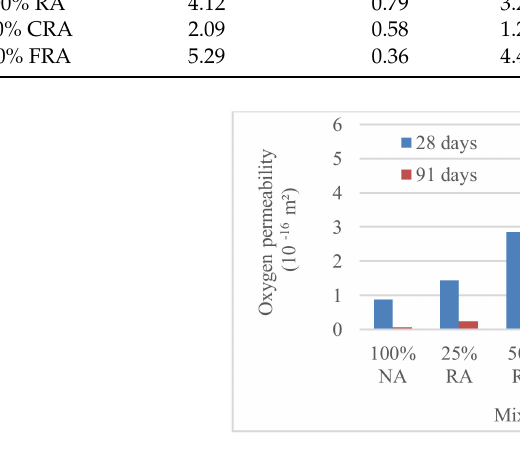
Figure 8. Oxygen permeability results at 28 and 91